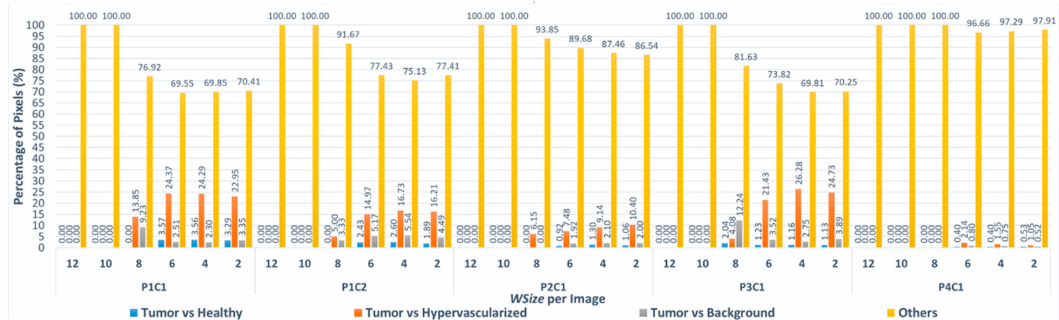
Figure 8. Percentage of pixels that have been misclassified using the Euclidean distance between tumor and healthy tissues (blue), tumor and hypervascularized tissues (orange), tumor tissue and background (gray) and the other misclassifications between healthy, hypervascularized and background (yellow). The results were obtained per each window size implementations compared to the WSize14 for each image of the